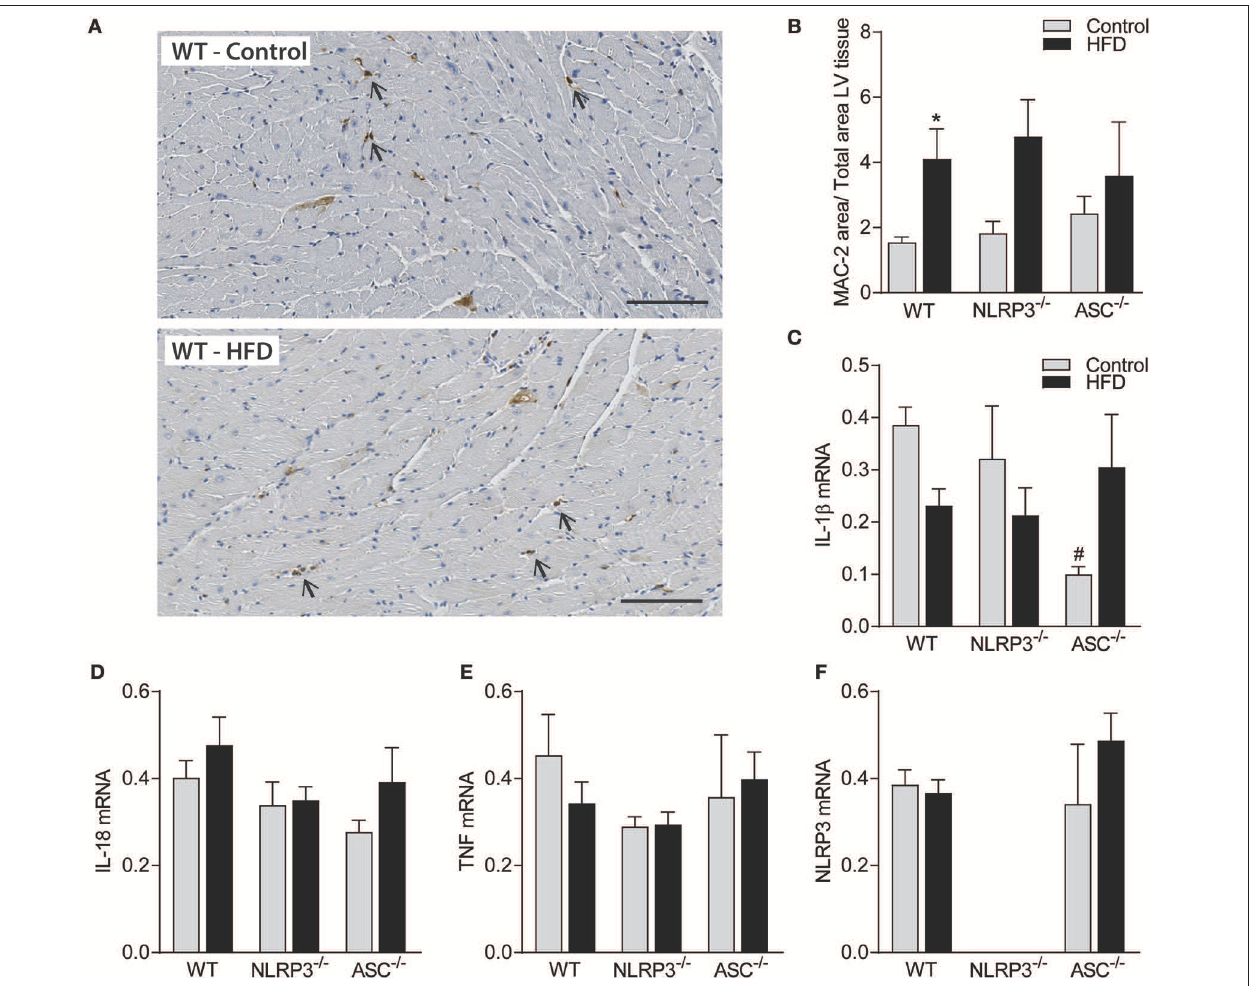
FIGURE 6 | Obesity-induced LV remodeling is not associated with cardiac inflammation. WT, Nlrp3 − / − , and Asc − / − ( Pycard − / − ) male mice were exposed to high fat diet (HFD; 60 cal% fat) or control diet for 52 weeks and cardiac inflammation was evaluated. (A) Representative images of Mac-2 positive macrophages (arrows) in left ventricle (LV) from a WT mouse on control diet and HFD. Scale bar: 100 µ m. (B) Quantification of Mac-2 positive areas in LV. LV gene expression, of (C) interleukin (IL)-1 β mRNA, (D) IL-18, (E) tumor necrosis factor (TNF), and (F) NLRP3, presented relative to levels of GAPDH mRNA. WT: Control, n = 10; HFD, n = 10, Nlrp3 − / − : Control, n = 7; HFD, n = 7, and Asc − / − ( Pycard − / − ): Control, n = 7; HFD, n = 7. Data are shown as mean ± SEM. * P < 0.05 vs. control diet; # P < 0.05 vs. WT-HFD as determined by two-way ANOVA and Tukey’s multiple comparisons